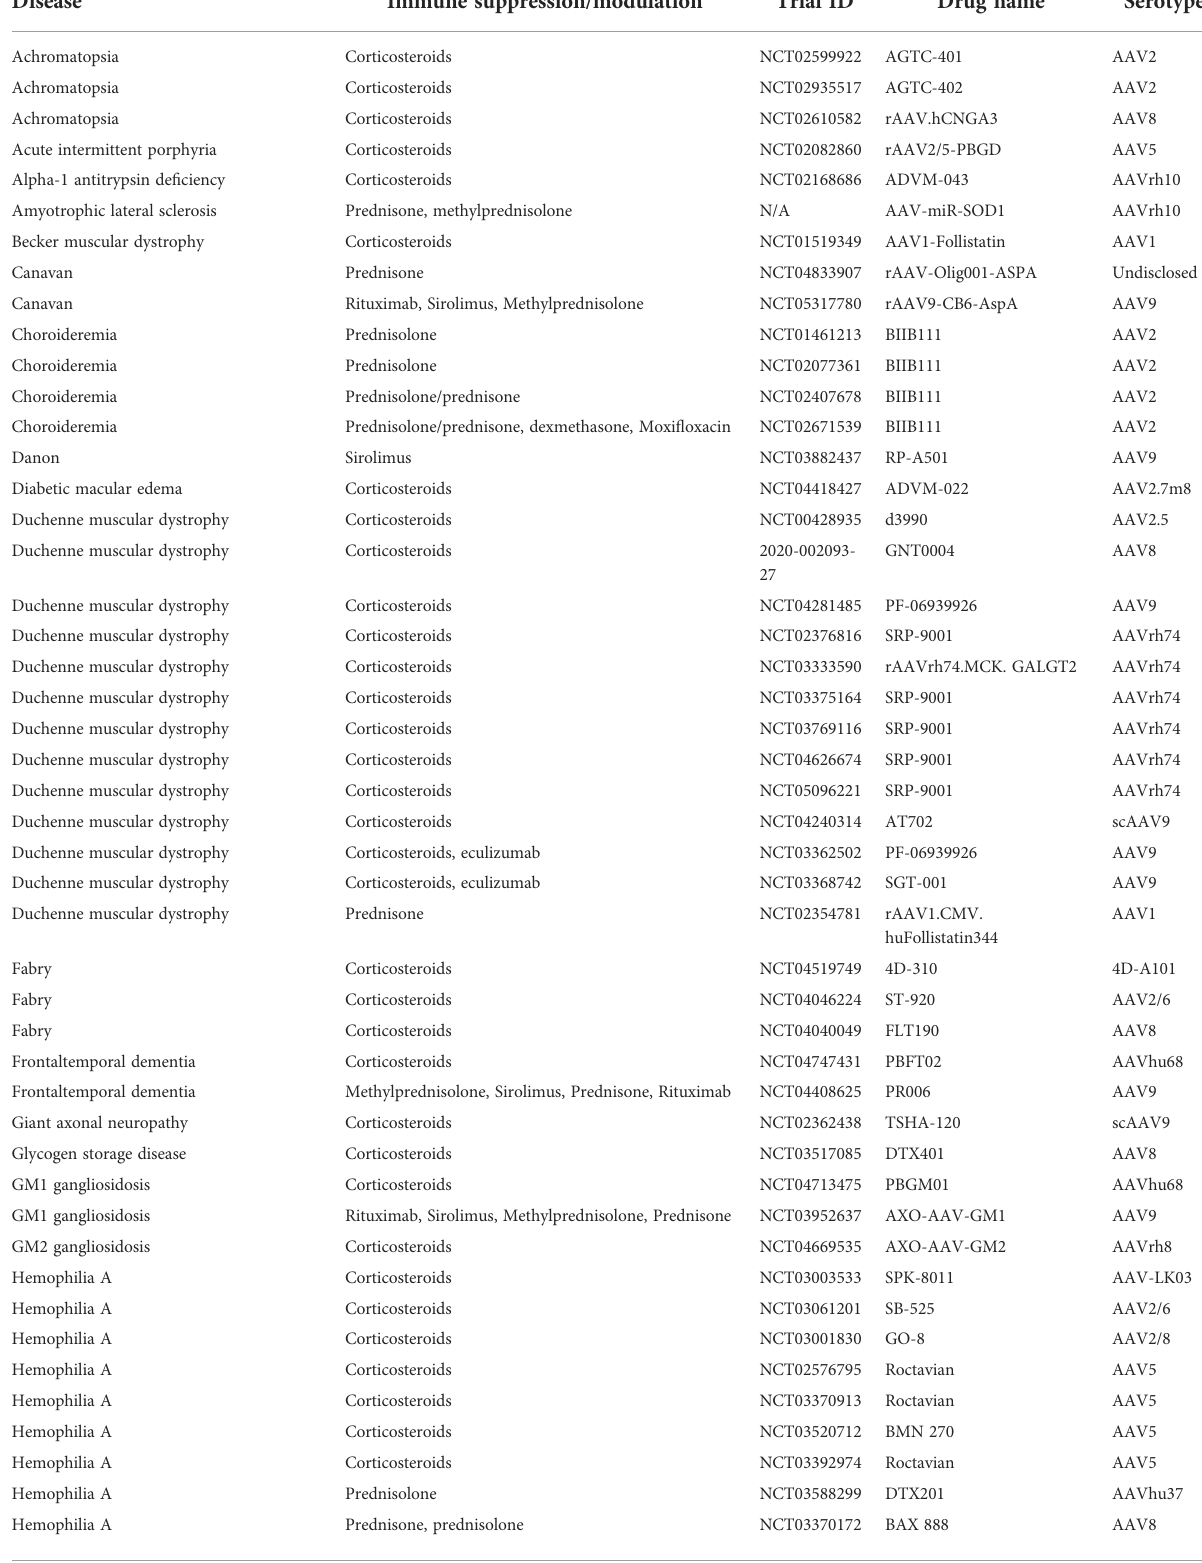
TABLE 2 AAV clinical studies using